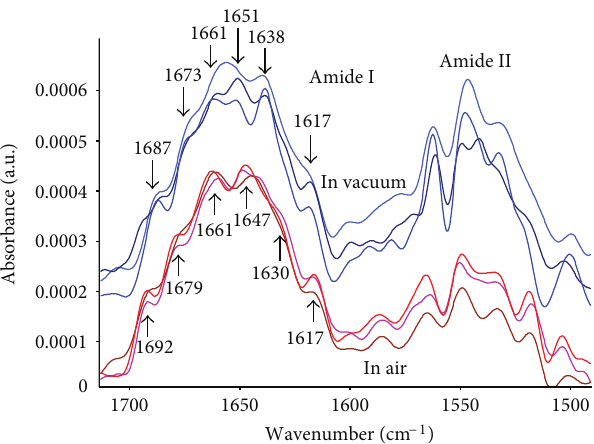
F 19: Self-deconvoluted FTIR ATR spectra of HRP attached on PIII-treated LDPE exposed to air (three bottom spectra) and vacuum (three top spectra) for three different samples of each treatment.espectrumtospectrumdeviationfordifferentsamples is stronger for samples that had protein attached in vacuum (top